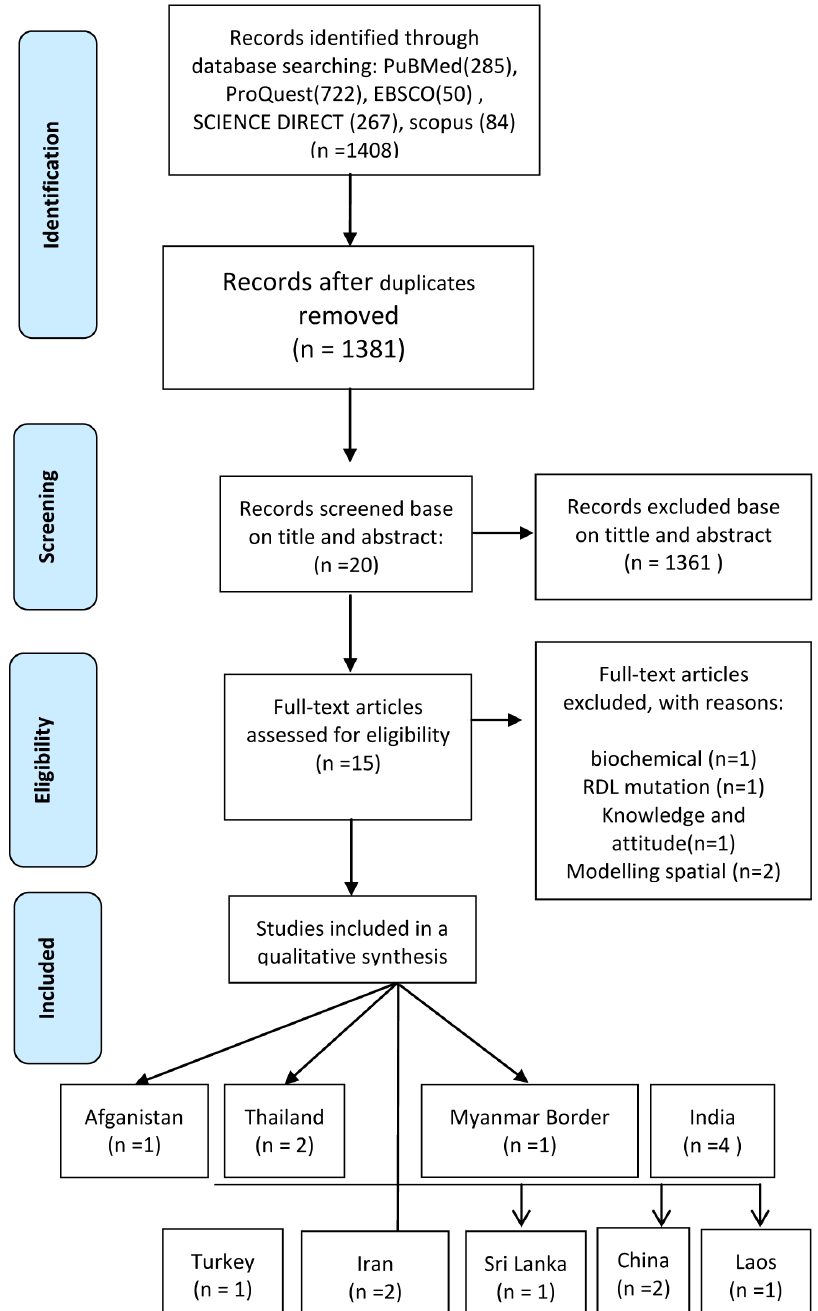
Figure 1. PRISMA flow diagram of systematic review inclusion and exclusion